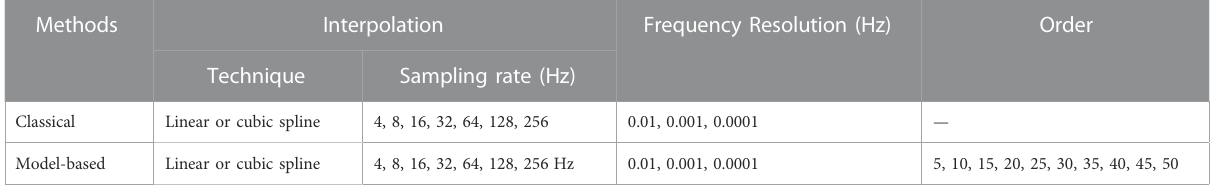
TABLE2Combinationsofparametersusedfortheextractionoffrequencyspectrafrompulseratevariabilitytrends.Frequencyresolution:numberofsamples used to calculate spectrum (nFFT) divided by the sampling rate of the signal.